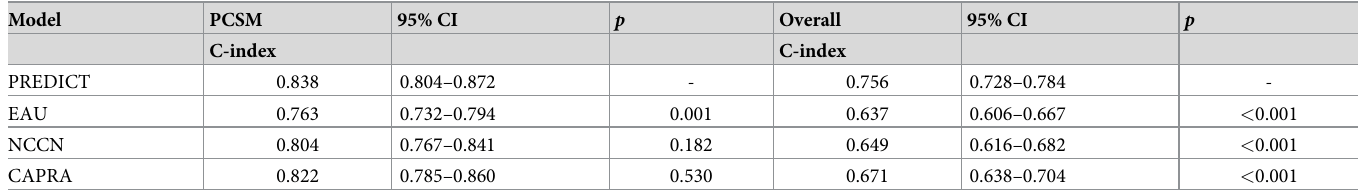
Table 6. Discrimination of the extended model, compared with other existing models amongst the Singaporean cohort over 15 years maximum follow-up ( n = 2,546).